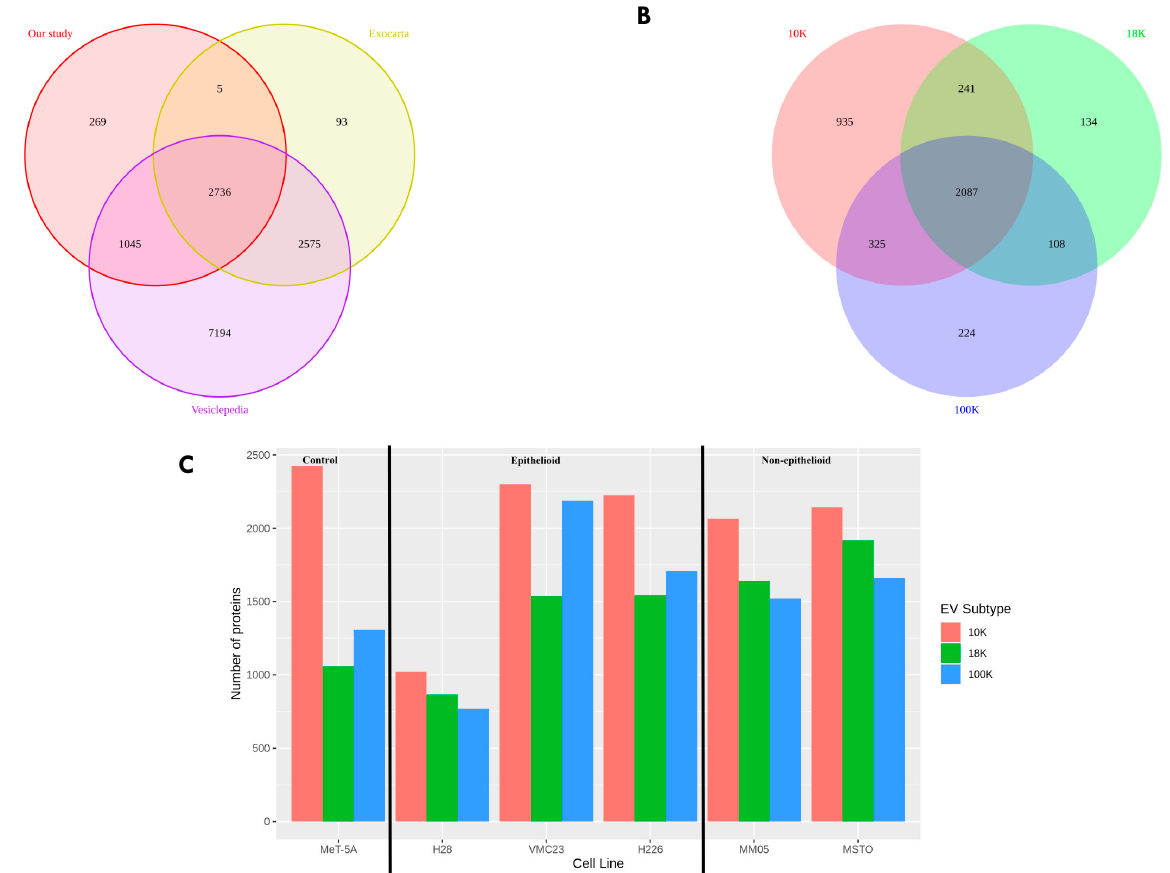
Figure 4. Proteome of EVs. ( A ) Venn diagram showing the overlap between the number of proteins that are enriched in the EVs from this study, with those in the Exocarta and Vesiclepedia databases (ExoCarta Version 5, Release date: 29 July 2015; Vesiclepedia Version 4.1, Release date: 15 August 2018). ( B ) Venn diagram showing the overlap between the number of proteins that are enriched in each of the EV subtypes from this study. ( C ) The number of proteins identified in each of the EV subtypes from each cell line. Data derived from four biological replicates.